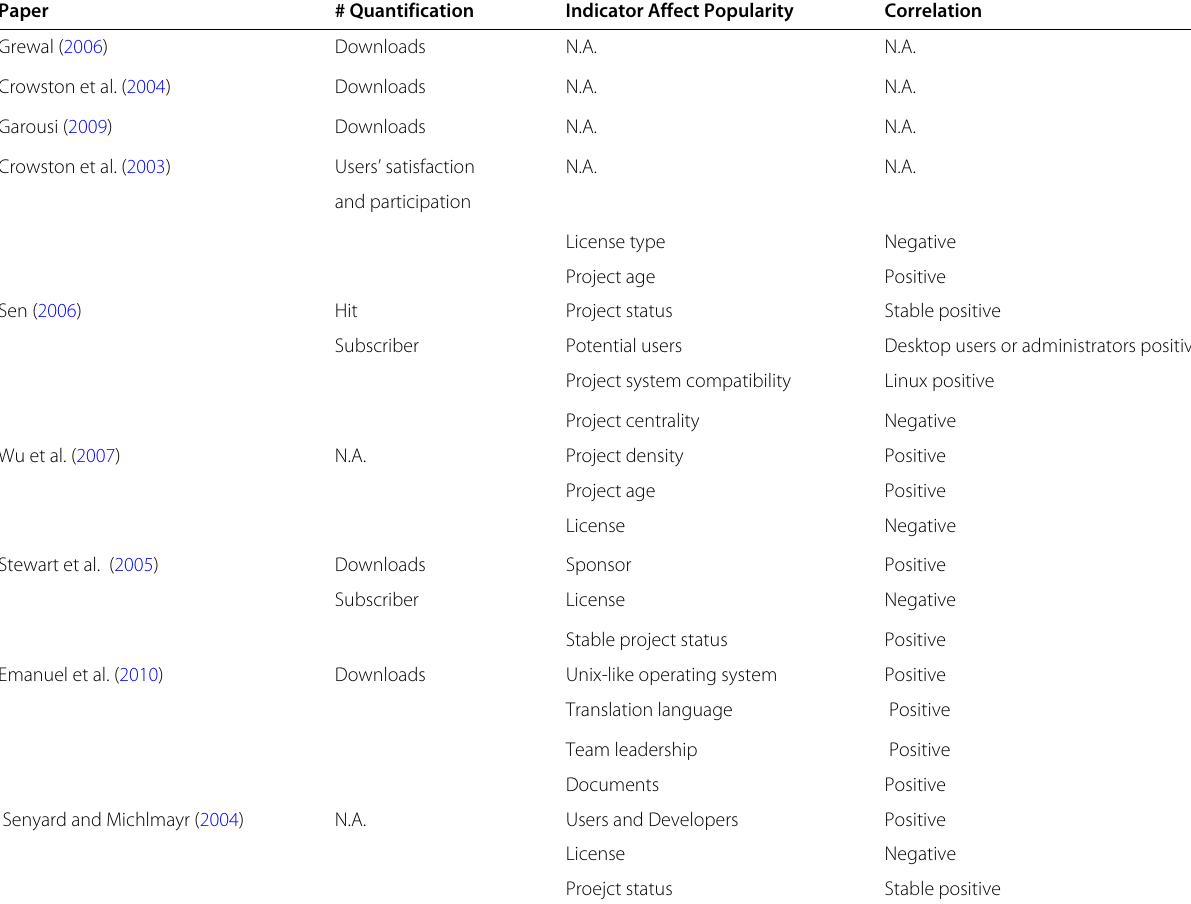
Table 5 The indicators about